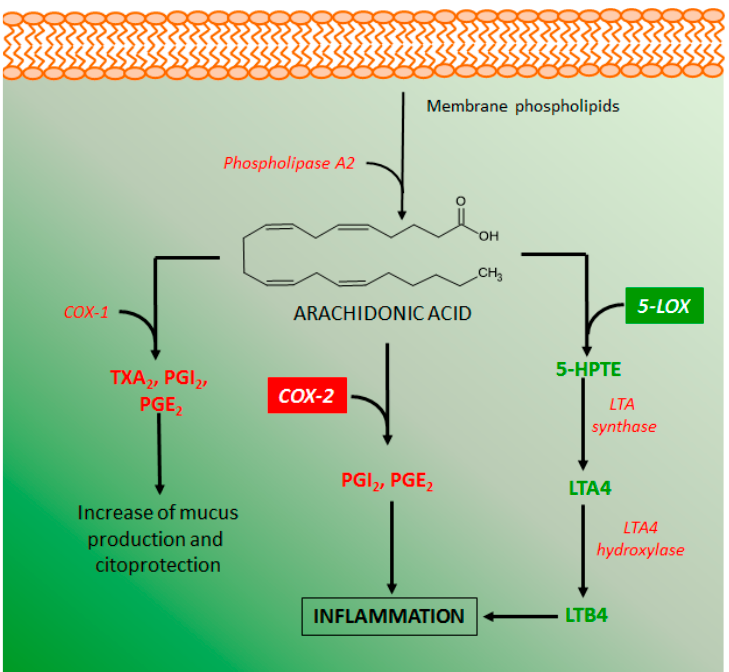
Figure 8. Arachidonic acid metabolism and its main pro ‐ inflammatory mediators. 5 ‐ LOX, 5 ‐ lipooxygenase; COX ‐ 1, cyclooxygenase 1; COX ‐ 2 cyclooxygenase 2; LTA, leukotriene A; LTB,